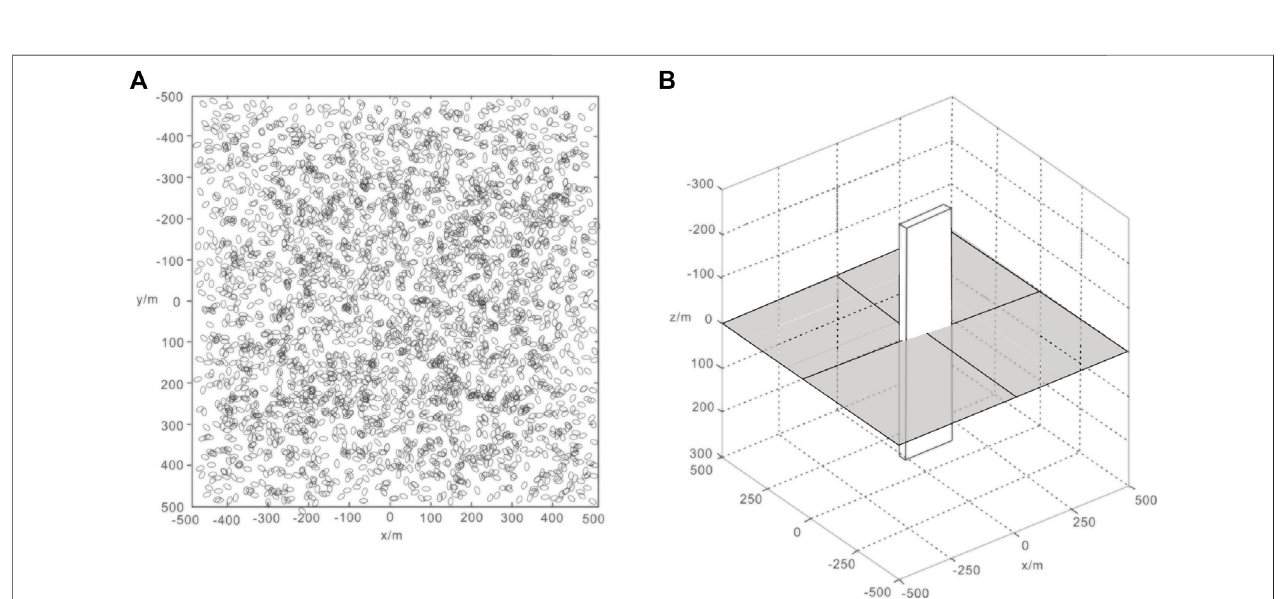
FIGURE 4 | Contour map of the gravity anomaly on the observation plane at z = -125 m.